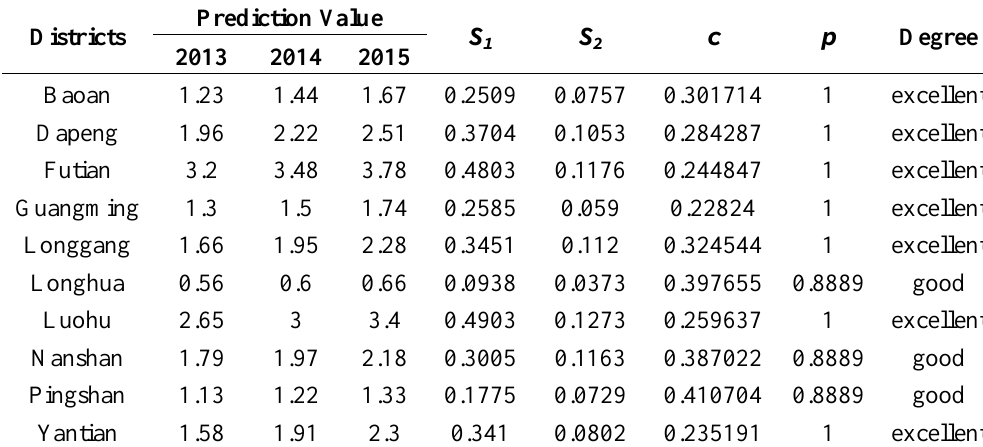
Table 1. Prediction of IHD IR based on GM (1,1).